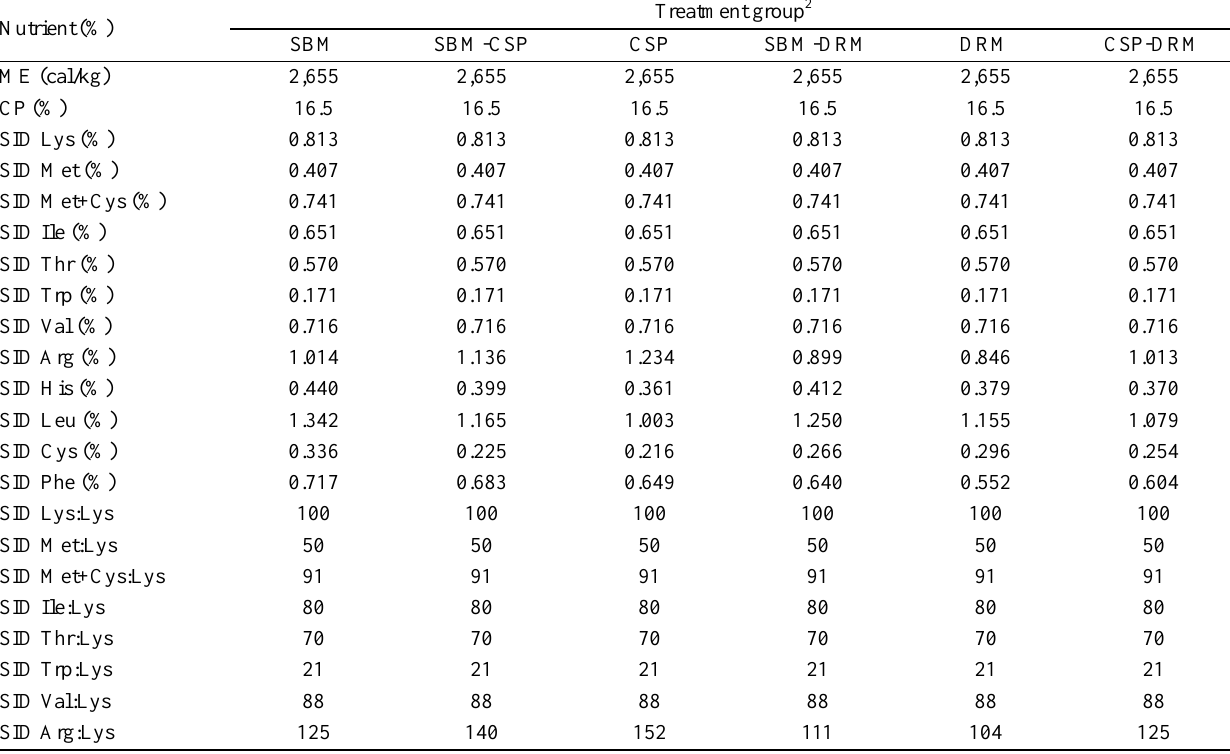
Table 2. AA Pattern of SID and AA concentration in the experimental diets 1